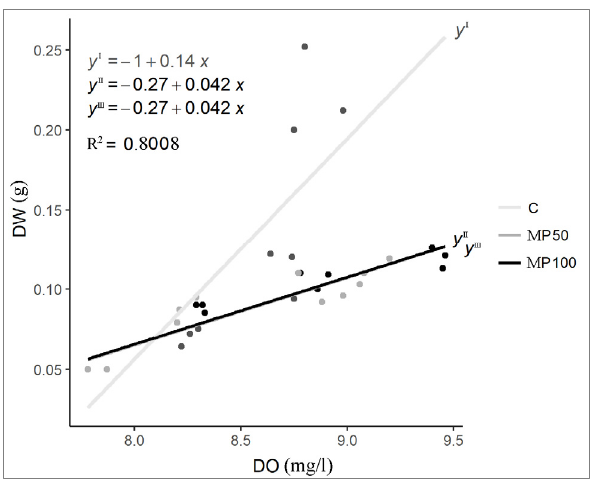
Figure 2. Regression model between DW and DO in control and microplastic treatments (MP50 and MP100). The regression lines of MP50 and MP100 are overlapping.